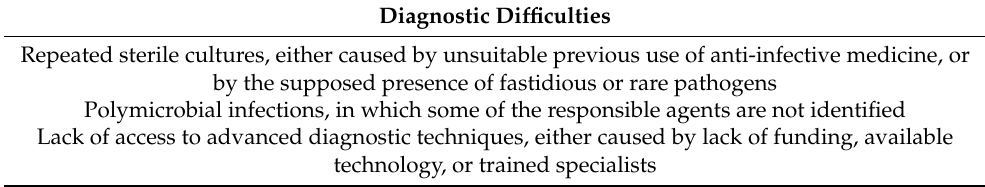
Table 1. Relevant causes for diagnostic failure.